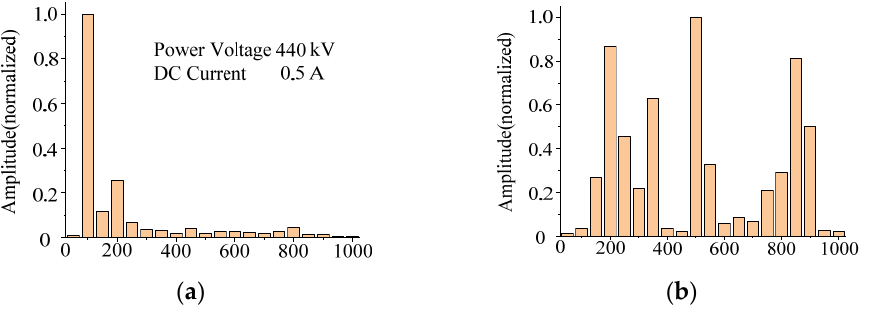
Figure 9. Comparison between the original spectrum and the calculated spectrum. ( a ) Core model frequency spectrum. ( b ) Simulated real transformer frequency spectrum.